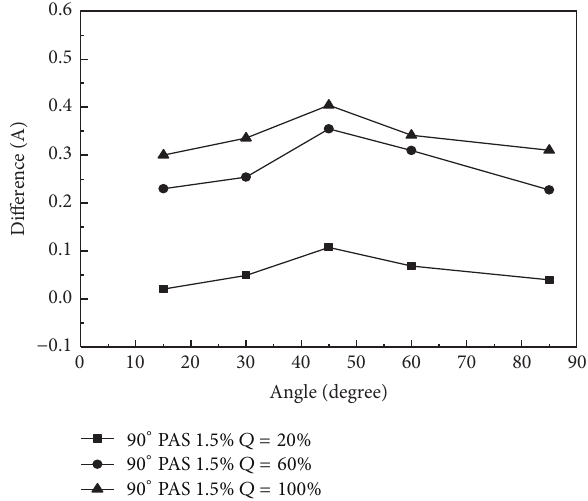
Figure 23: The PAS 1.5% angle of curved tube: difference diagram of various flows in 135 ∘ curved tube.